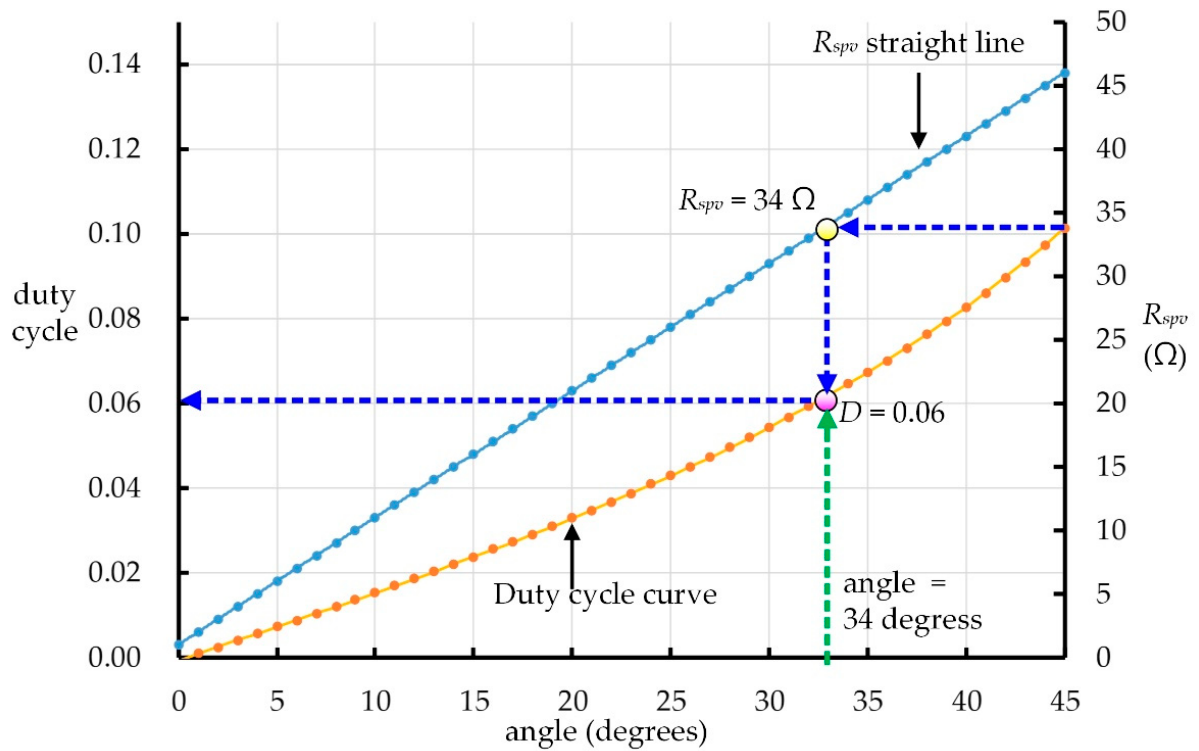
Figure 9. The relationship between R spv , angle θ 1 , and duty cycle D .